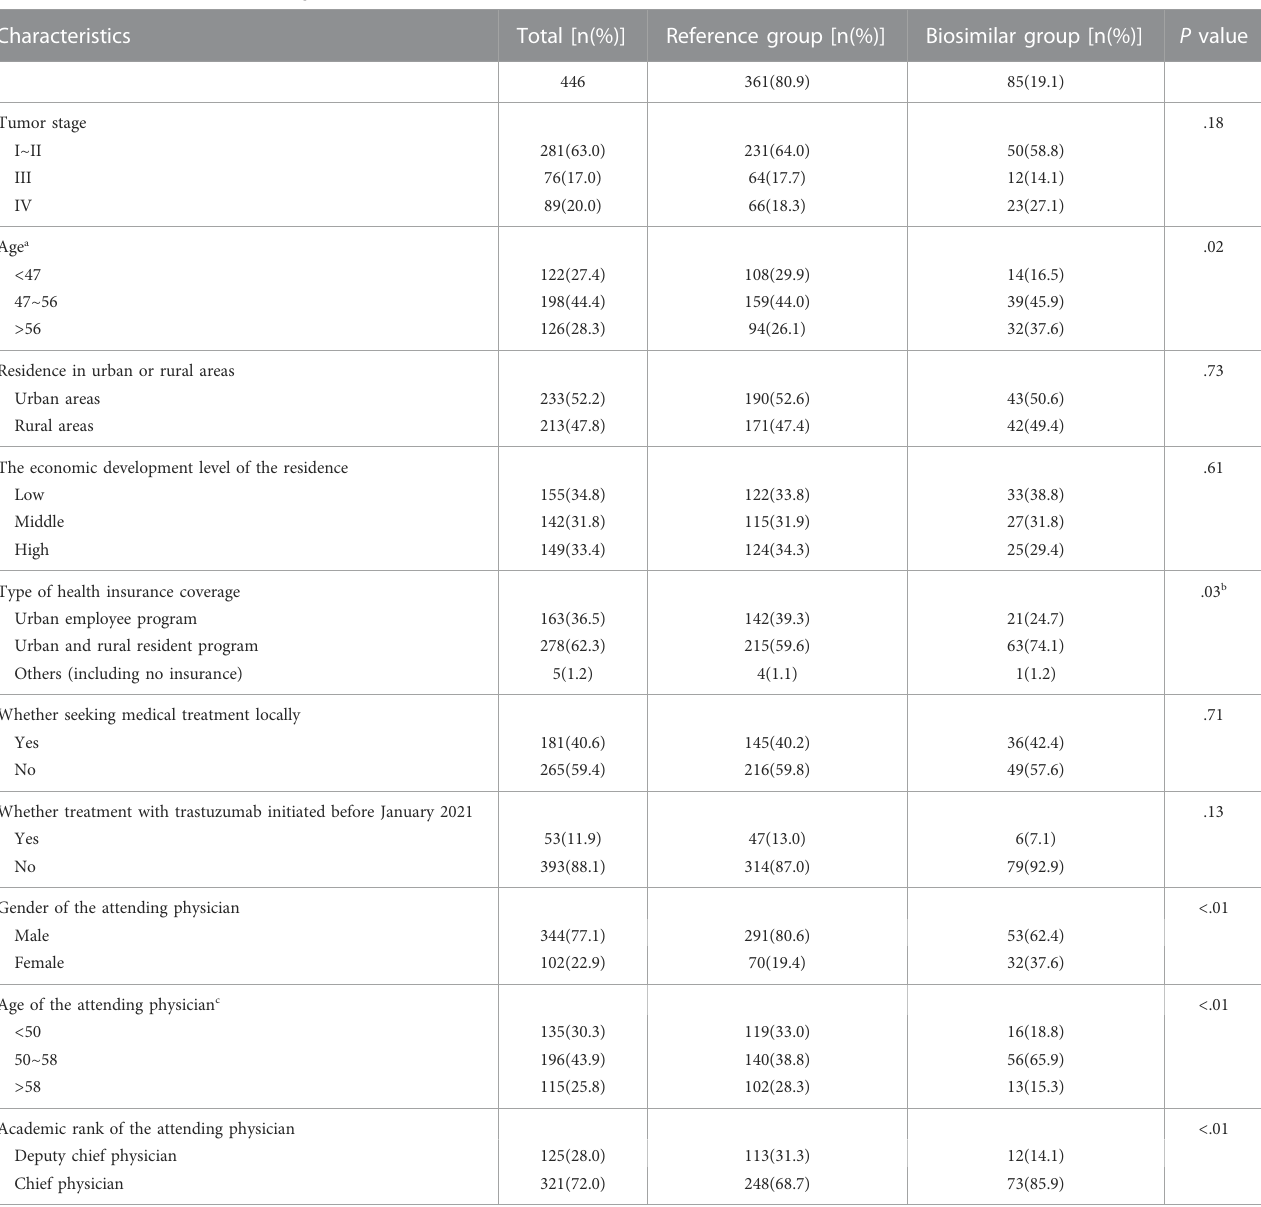
TABLE 1 Characteristics of the included